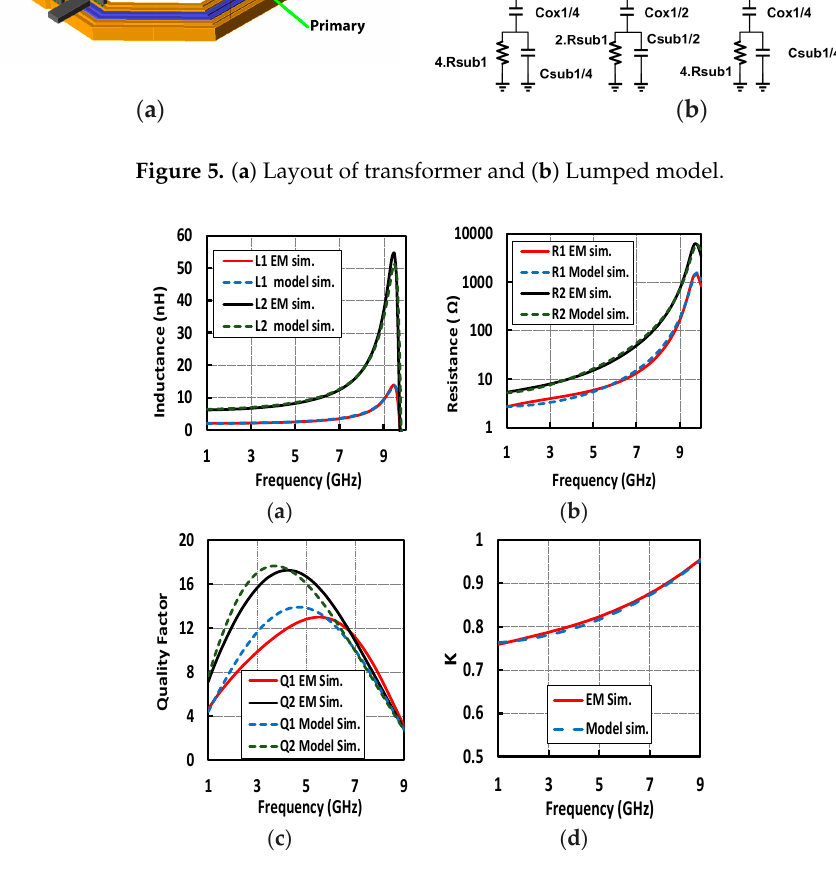
Figure 6. Simulation results of EM and lumped model of transformer, ( a ) inductance, ( b ) loss, ( c ) Quality factor, ( d ) coupling factor.